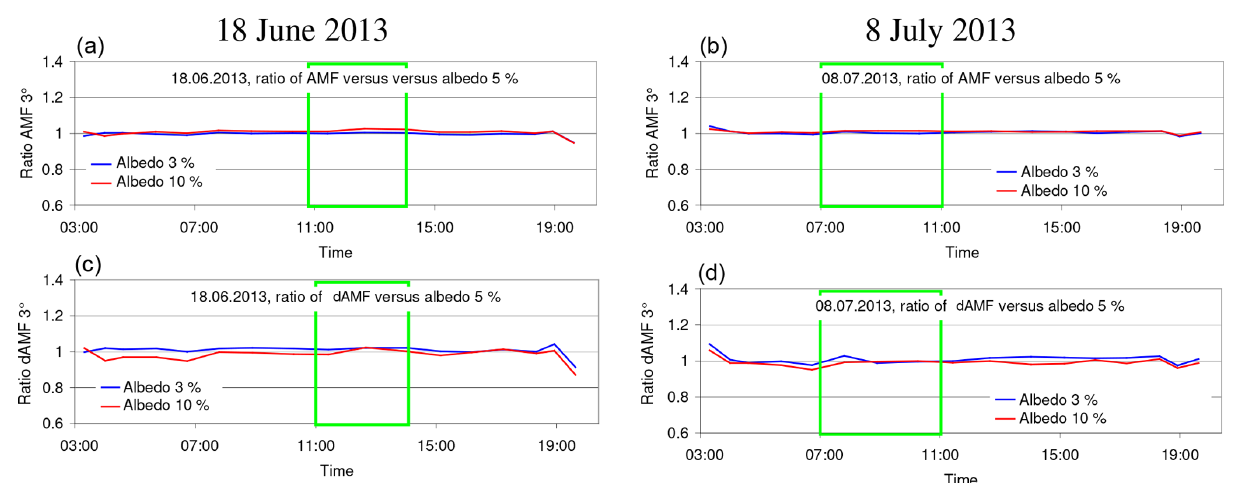
Figure A12. Ratios of the O 4 AMFs (a, b) and O 4 dAMFs (c, d) for different surface albedos vs. those for an albedo of 5% for both selected days.